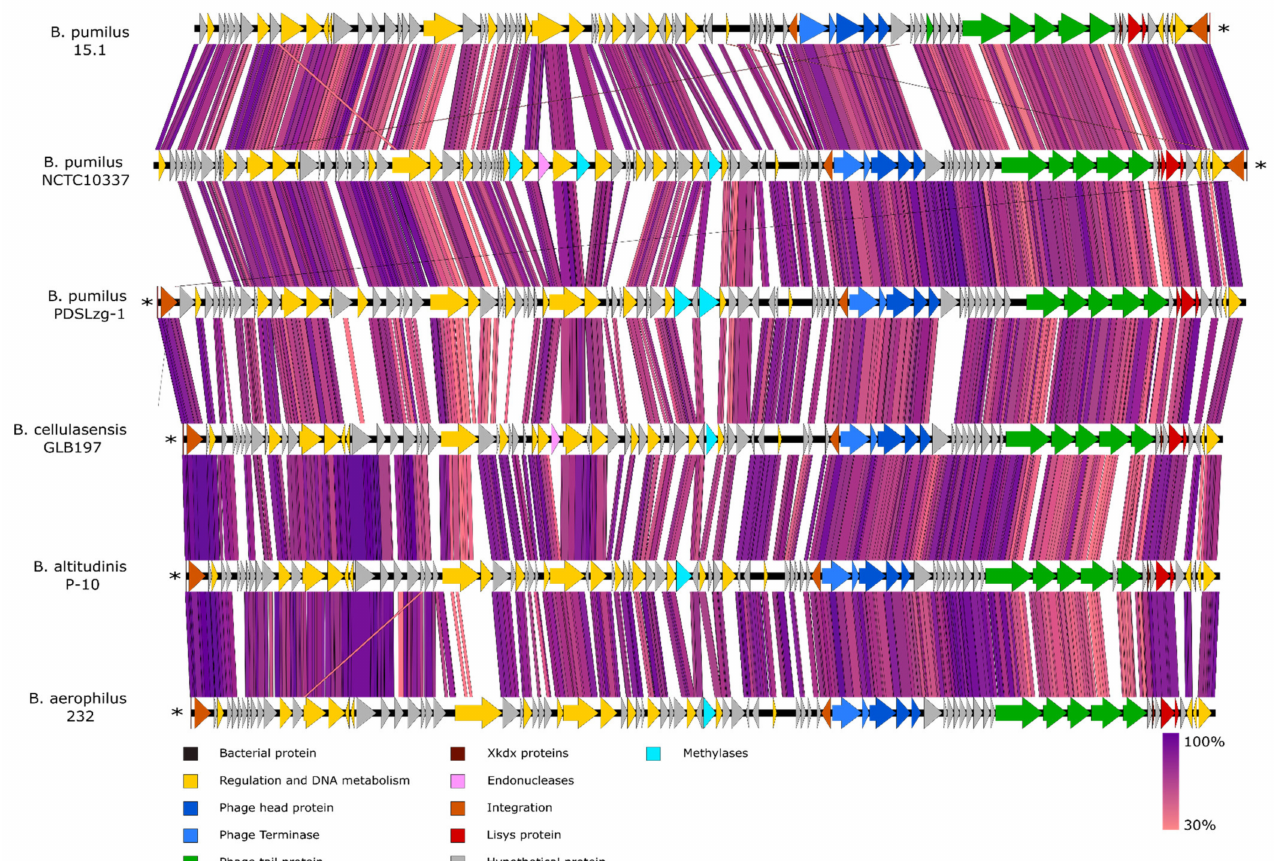
Figure 5. Comparative analysis of the 60.2 Kb insertion fragment among different B. pumilus related species. The potential function of each ORF was inferred by Blastp and shown as coloured arrows. tRNAs position are indicated by asterisks. Homology studies were made by tBlastx and plotted with Easyfig with a minimal length of 50